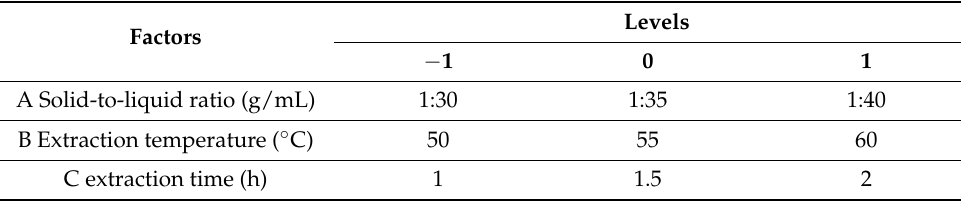
Table 4. The factors and levels of